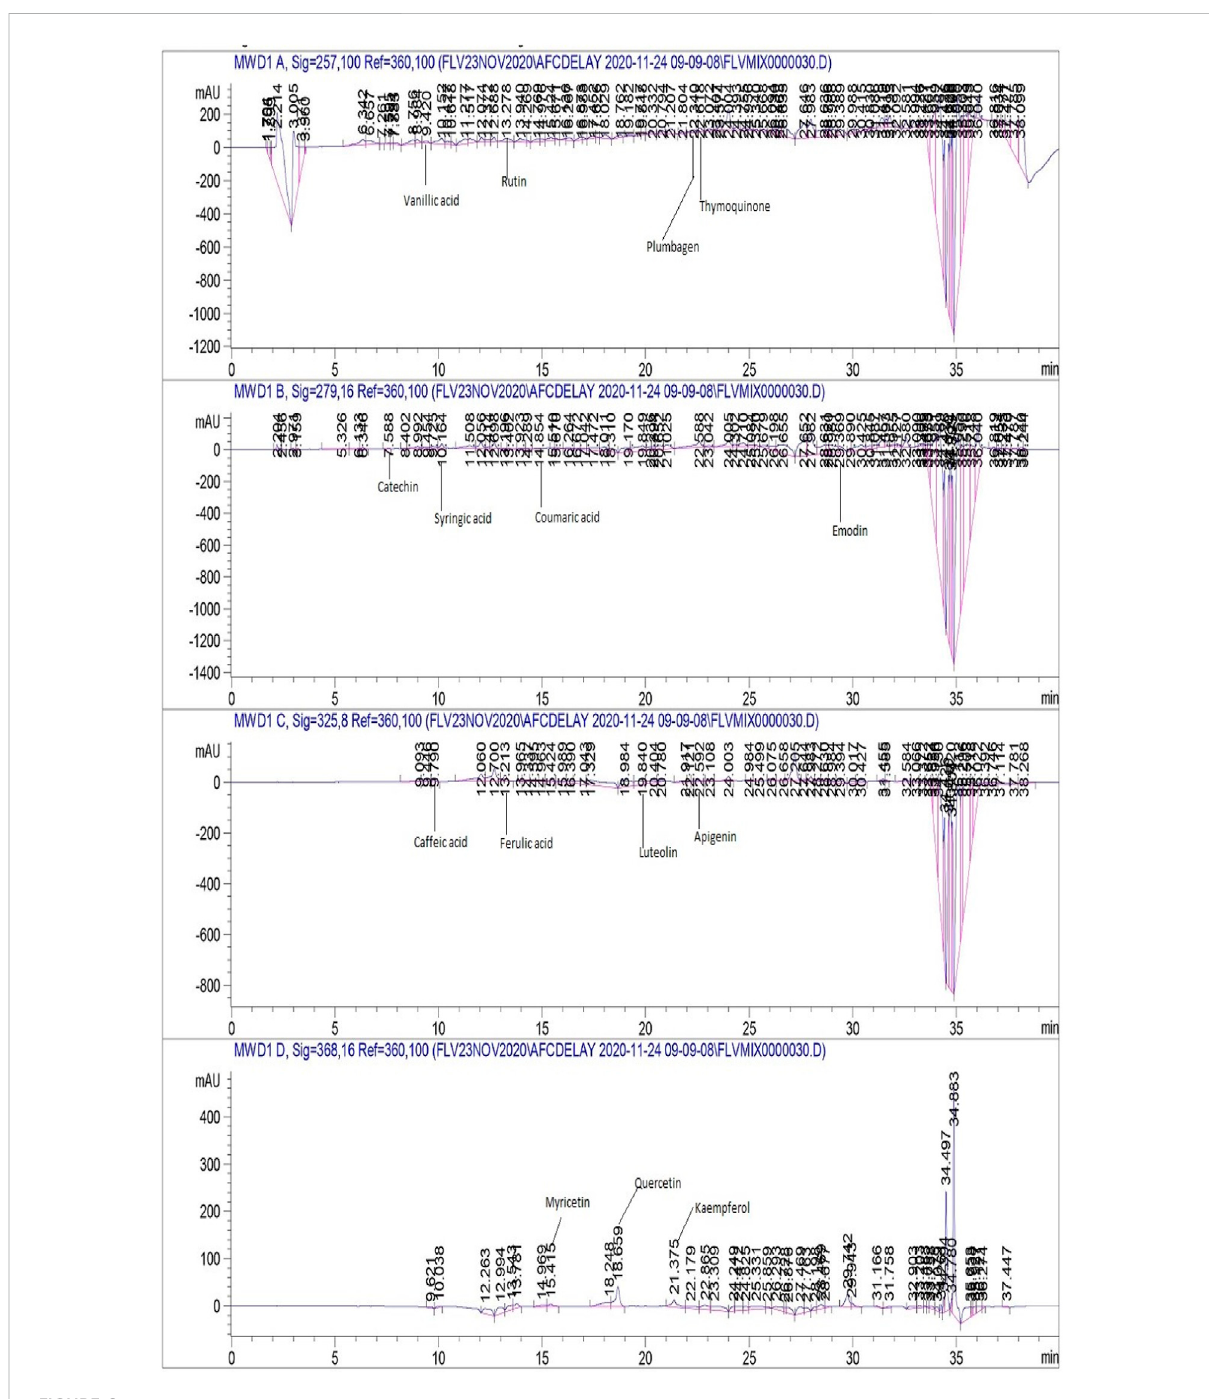
FIGURE 6 HPLC chromatogram of A. indica EA